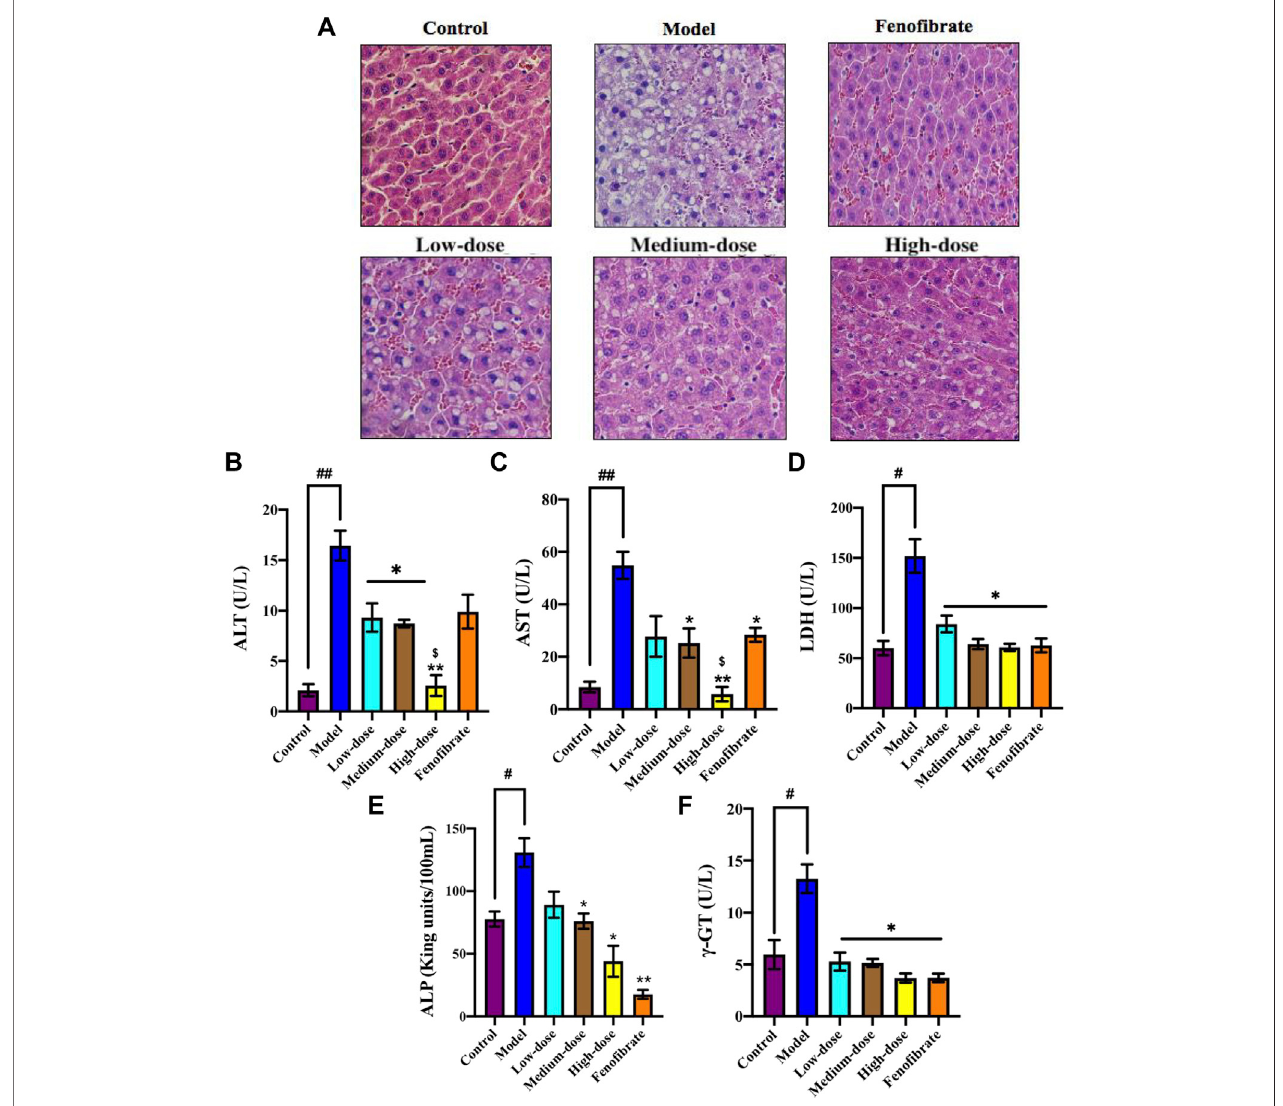
FIGURE 6 | The protective effect of Ey-TFH on the liver. (A) HE staining. (B) ALT; (C) AST; (D) LDH; (E) ALP; (F) γ -GT. # p < 0.05, ## p < 0.01, compared with the control group; * p < 0.05, ** p < 0.01, compared with the model group; $ p < 0.05, compared with the positive control group.